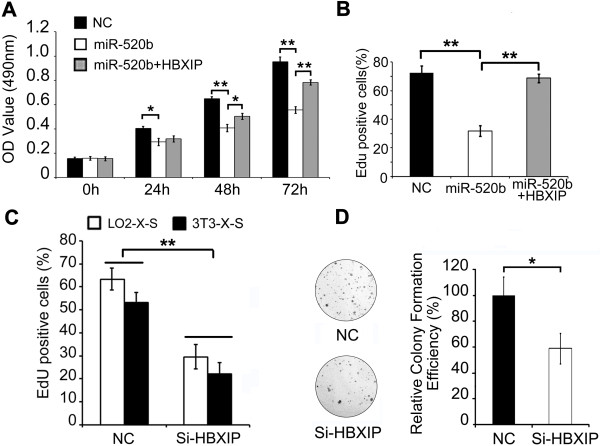
MiR-520b/HBXIP modulates proliferation of LO2-X-S cells in vitro. (A-D) The effects of miR-520b, miR-520b/HBXIP or si-HBXIP on proliferation of LO2-X-S cells were examined by MTT, EdU incorporation or colony-formation assays, respectively. Si-NC refers to negative control of HBXIP siRNA. Data are shown as mean ± SD of three independent experiments (*P < 0.05, **P < 0.01, Student’s t test).